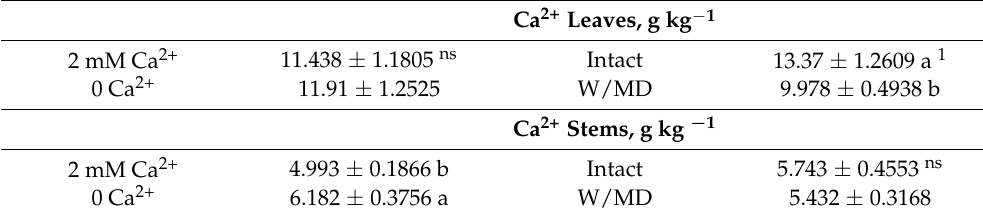
Table 1. Calcium concentration in the leaves and stems of Annona emarginata cultivated with 0 and 2 mM Ca 2+ , with or without mechanical damage at 90 days after mechanical